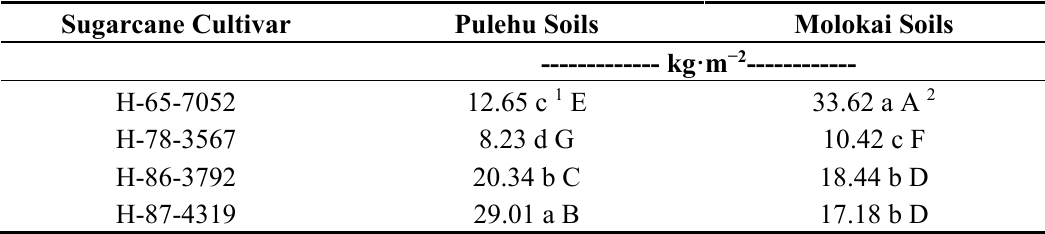
Table 4. Soil Organic Carbon Accumulation In Soil from Tillering to Maturity